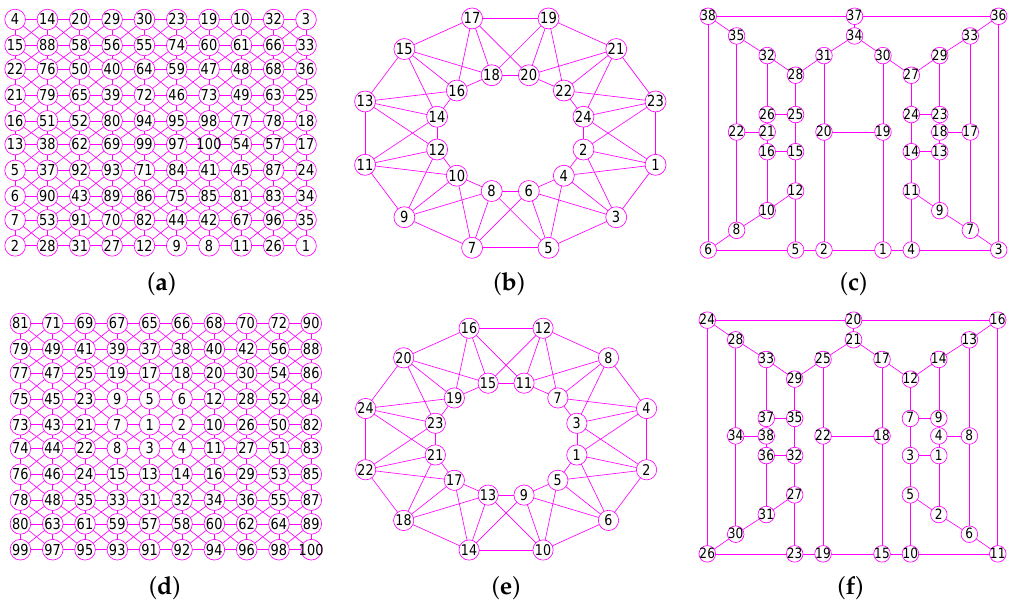
Figure 11. The TopMost graphs of three graphs G 5 , G 6 and G 7 . ( a ) The 10 × 10 king graph G 5 of 100 vertices and 342 edges; ( b ) The musical graph G 6 of 24 vertices and 60 edges; ( c ) The Barnette-Bosák-Lederberg graph G 7 of 38 vertices and 57 edges; ( d ) The TopMost graph of G 5 ; ( e ) The TopMost graph of G 6 ; ( f ) The TopMost graph of G 7 .